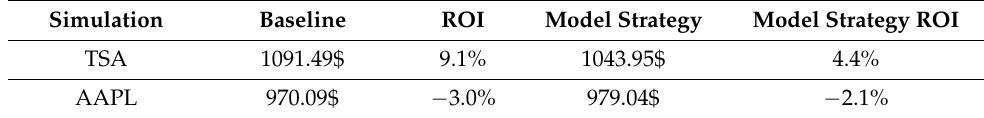
Table 12. Summary of the